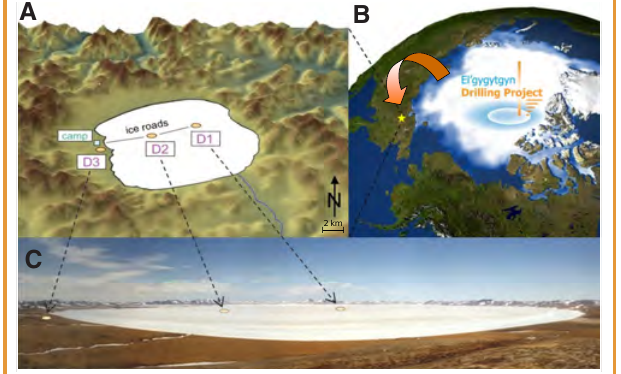
Figure 1. [A] Digital elevation model, [B] drill site locations, projected onto a panoramic view of Lake El’gygytgyn in May facing north, [C] location of Lake El’gygytgyn at 67.5 o N and 172 o E, ~100 km north of the Arctic Circle in Chukotka, northeastern Russia (base map courtesy of Arctic Climate Impact